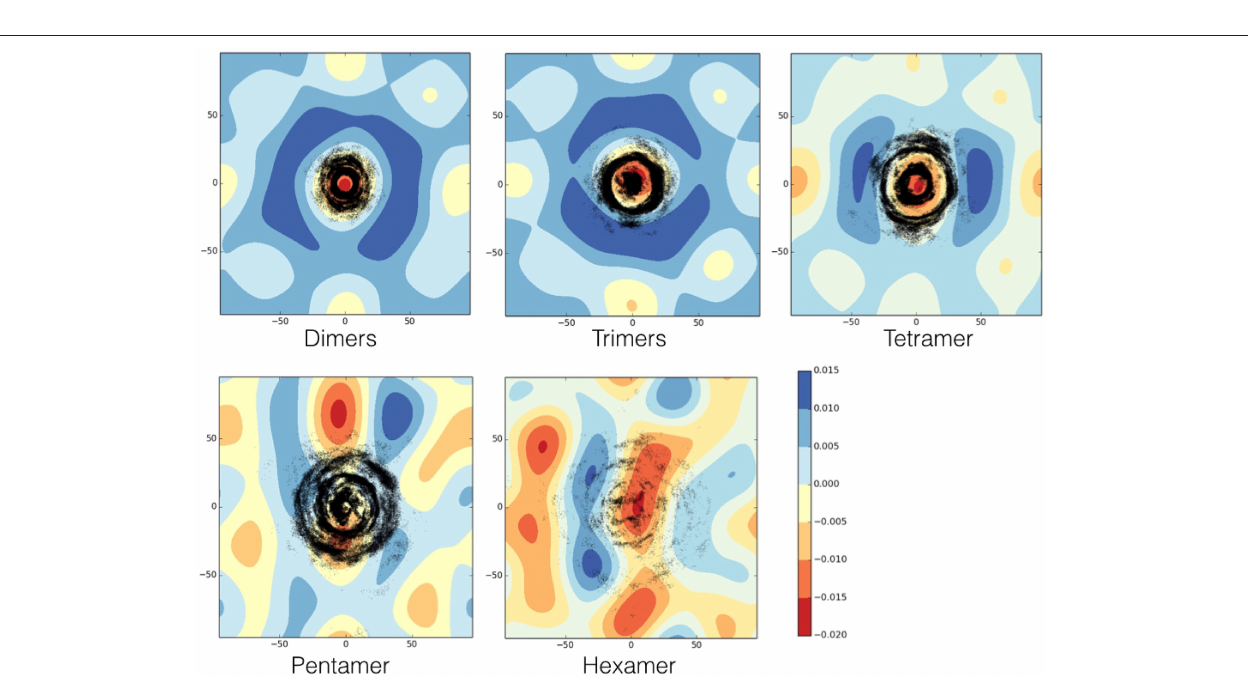
FIGURE 10 | Left: Plot of the number of contacts of the residues of each TFP monomer with the membrane. Right: The residues that are interacting the most with the membrane are highlighted in red on the TFP monomer structure.